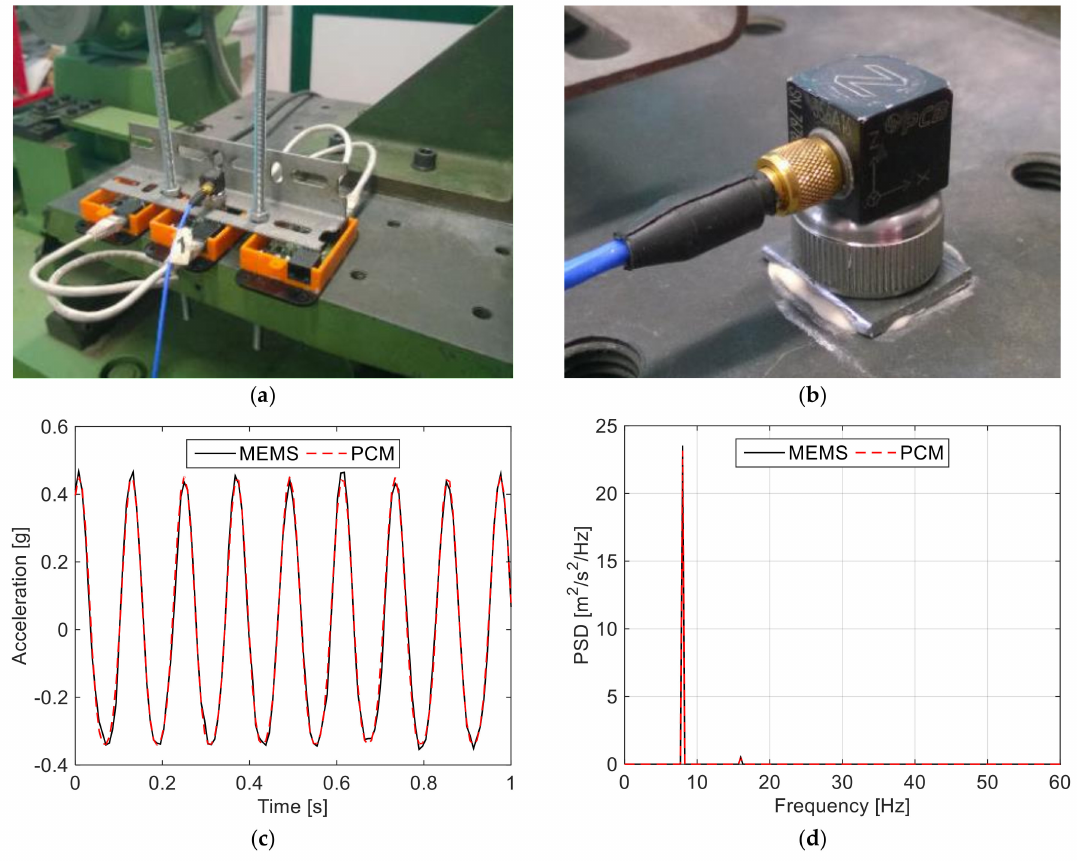
Figure 2. Laboratory shaking table tests: ( a ) MEMS and ( b ) comparative PCM sensors; ( c , d ) examples of test measurements in terms of acceleration-time plots and pseudo-spectral density